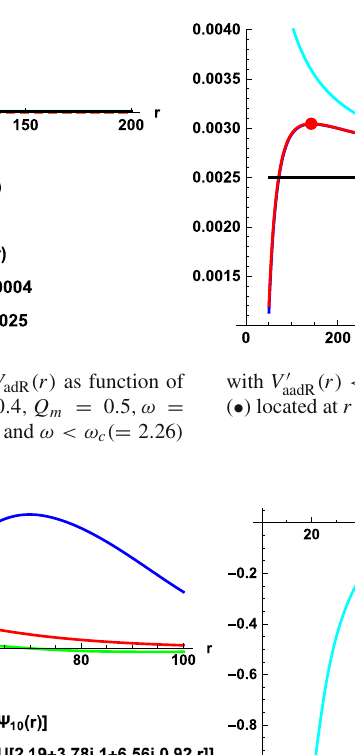
( r ) (cid:17) (cid:17) ( r ) with U [ 3 . 6 , 7 . 3 , 0 . 92 r ] represent bound states appeared in (left) Fig. 3 3 3